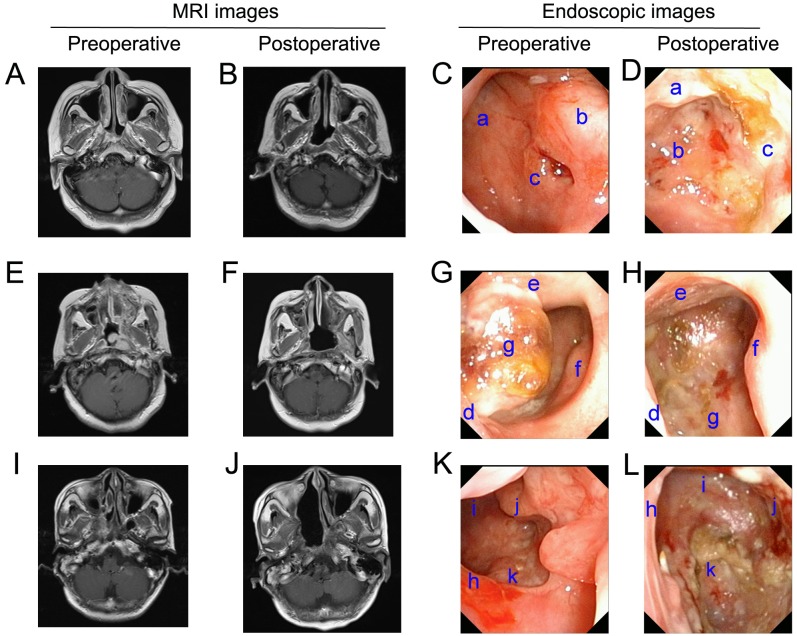
Pre- and post-operative MRI and high-definition endoscopic images.(A) Pre-operative MRI shows that the tumor is located in the right pharyngeal recess (rT1). (B) The 6-months post-operative MRI did not show tumor recurrence. (C and D) The 6-months post-operative endoscopic examination images show no visible tumor recurrence. Labels in the pre-operative endoscopic images: a, nasopharyngeal posterior wall; b, right torus tubarius; c, nasopharyngeal carcinoma. Post-operative: a, soft palate; b, nasopharyngeal posterior wall; c, nasopharyngeal right wall. (E) Pre-operative MRI shows the tumor invading the left pharyngeal space (rT2). (F) Post-operative MRI after six months did not show tumor recurrence; (G & H) The 6-months post-operative endoscopic examination images show no visible tumor recurrence. Labels in the Pre-operative endoscopic images: d, nasal septum; e, soft palate; f, right torus tubarius; g, nasopharyngeal carcinoma; Post-operative: d, nasal septum; e, soft palate; f, nasopharyngeal right wall; g, clivus. (I) Pre-operative MRI shows the tumor invading the base of the skull (rT3); (J) post-operative MRI after six months did not show tumor recurrence; (K and L) The 6-months post-operative endoscopic examination images show no visible tumor recurrence. Labels in the pre-operative endoscopic images: h, nasal septum; i, nasopharyngeal posterior wall; j, right torus tubarius; k, nasopharyngeal carcinoma; Post-operative: h, nasal septum; i, nasopharyngeal posterior wall; j, nasopharyngeal right wall; k, clivus.